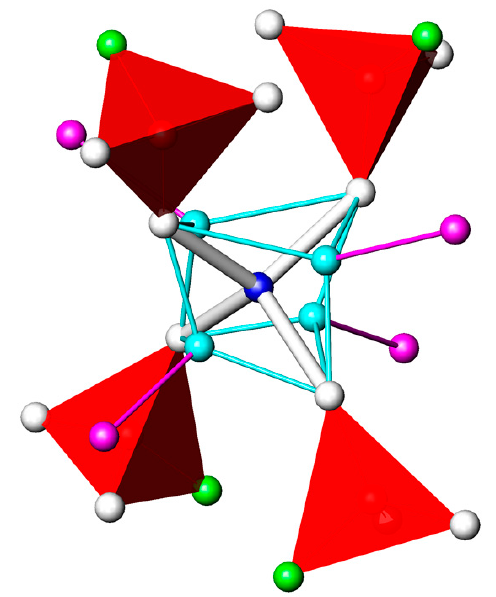
Figure 12. Disorder in the crystal structure of (NH 4 ) 2 Zn 3 (PO 3 F) 4 (H 2 O). Colour code of the PO 3 F tetrahedra as in Figure 1. The major part of the disordered Zn site (ZnA) is given as a blue sphere, the minor part (ZnB) as a turquoise sphere. The statistically occupied (NH 4 /H 2 O) site is given in magenta. For clarity, H atoms are not shown.